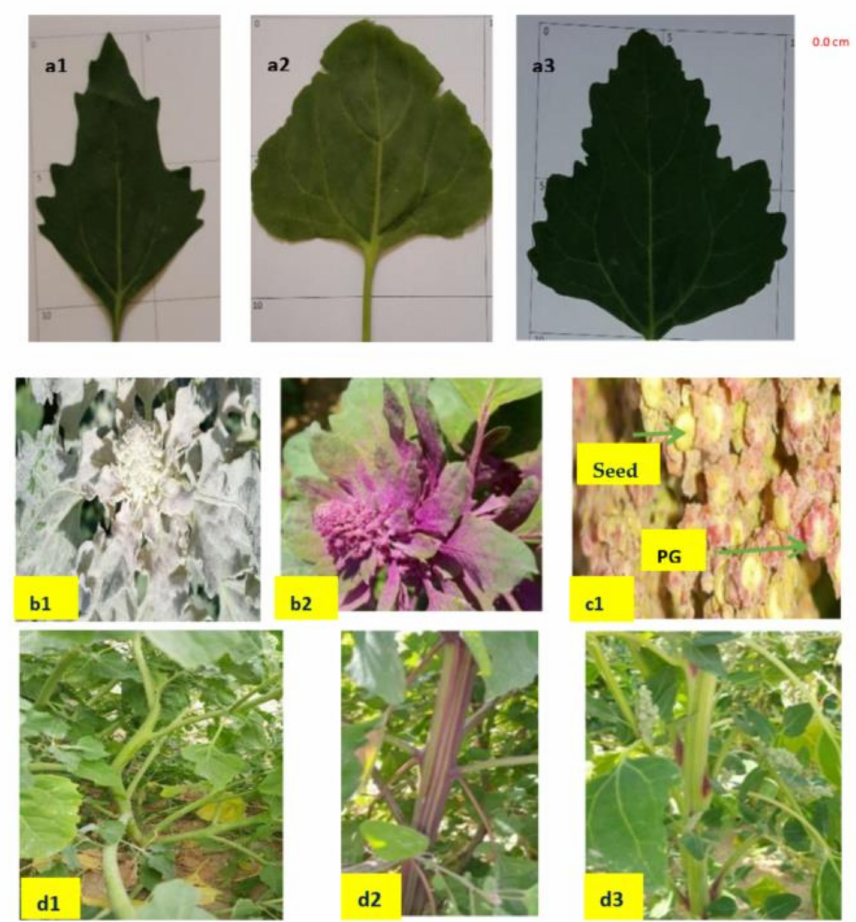
Figure 1. a1 : Rhomboidal leaf shape with dentate margin. a2 : Triangular leaf shape. with entire margin, a3 : Triangular leaf shape with a high number of teeth on a serrate margin. b1 : White leaf granules. b2 : Purple leaf granules. c1 : Semi-open perigonium. d1 : Oblique branch position. d2 : Stem striae. d3 : Pigmented